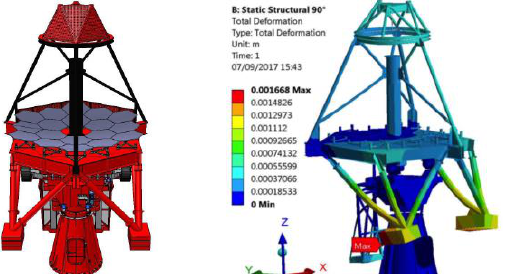
Figure 2. Left: the design of the ASTRI structure for the array of pathfinders (courtesy of GEC). Right: example of Finite Element Analysis for the new structure (courtesy of